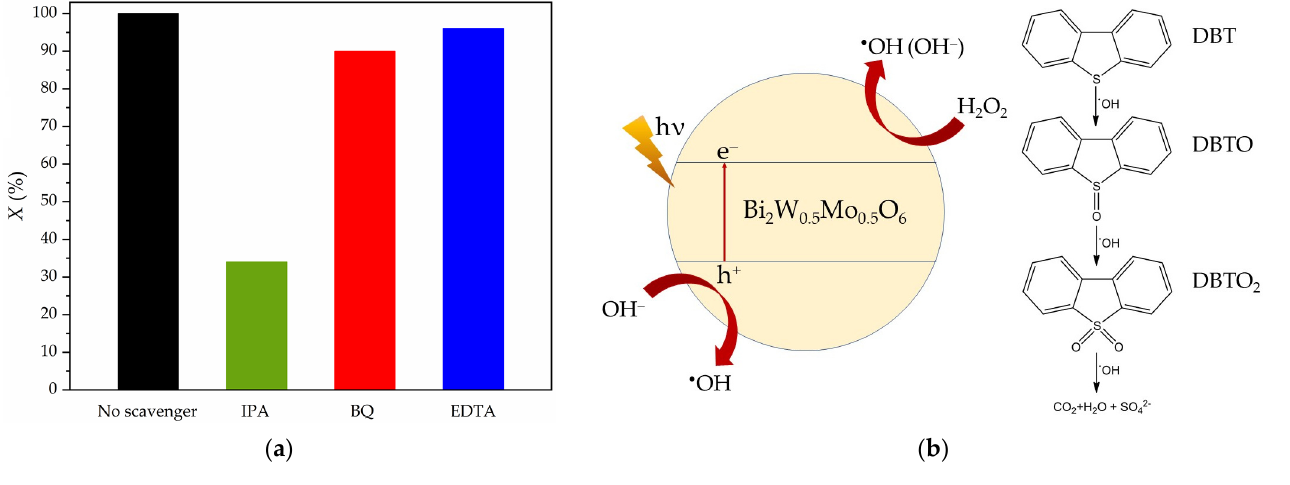
Figure 6. ( a ) Desulfurization degree after 120 min in the presence of free radical scavengers (10 mL of model fuel, 200 ppm S, 0.1 g of Bi 2 W 0.5 Mo 0.5 O 6 photocatalyst, H 2 O 2 /DBT molar ratio of 10, 30 W LED lamp as the visible light source, a distance of 10 cm from the light source to the model fuel) and ( b ) possible mechanism of photocatalytic oxidation of DBT on Bi 2 W 0.5 Mo 0.5 O 6 . During the photocatalytic process, the Bi 2 W 0.5 Mo 0.5 O 6 photocatalyst can be